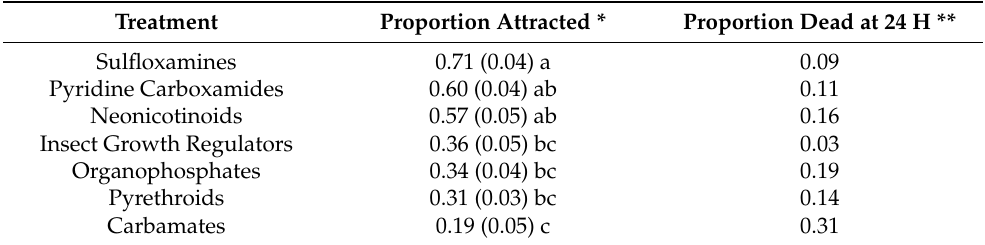
Table 2. Proportion of tarnished plant bug nymphs attracted to treated green beans 24 h after treatment in laboratory bioassays during 2014 and 2015.